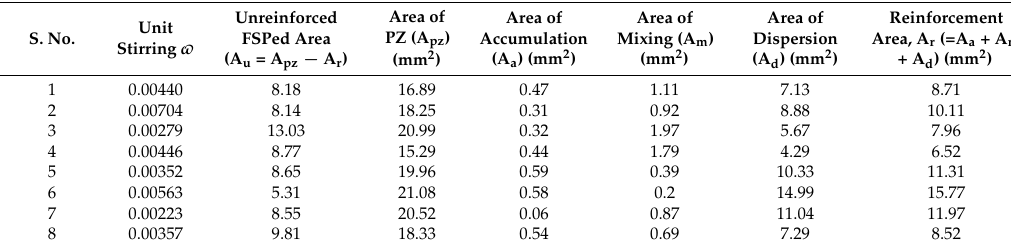
Table 3. Processed zone (PZ) dimensions.